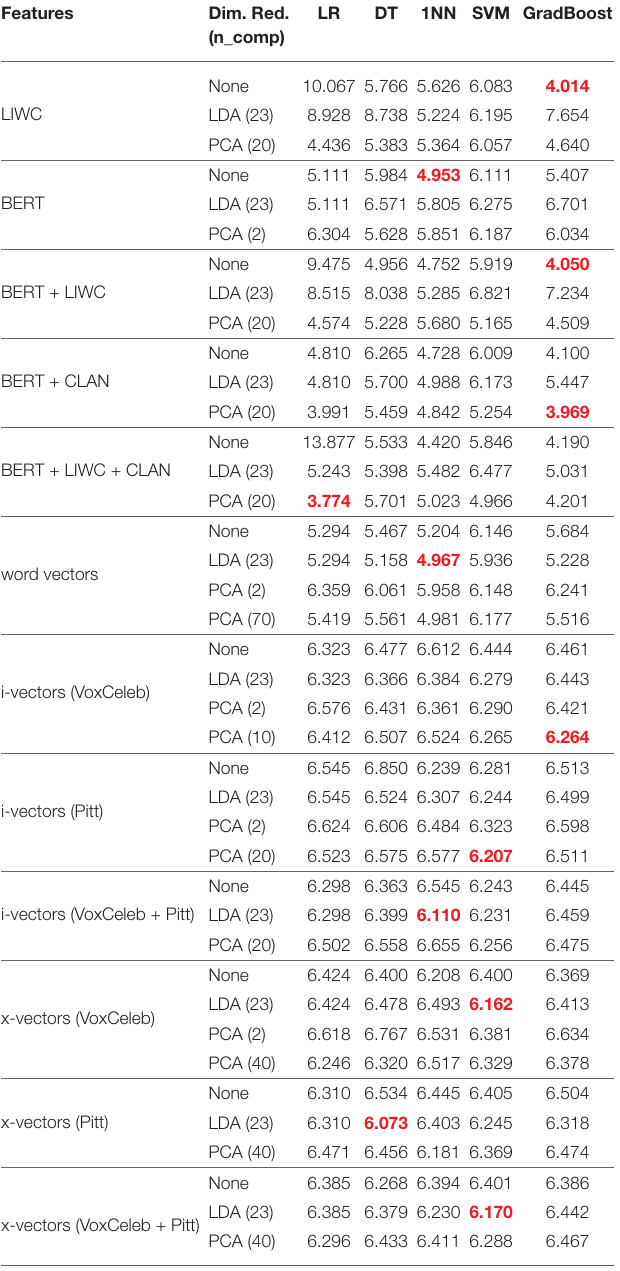
TABLE 5 | LOSO RMSE scores for each of the classifiers. The results for the best-performing models for each feature type are red. Features